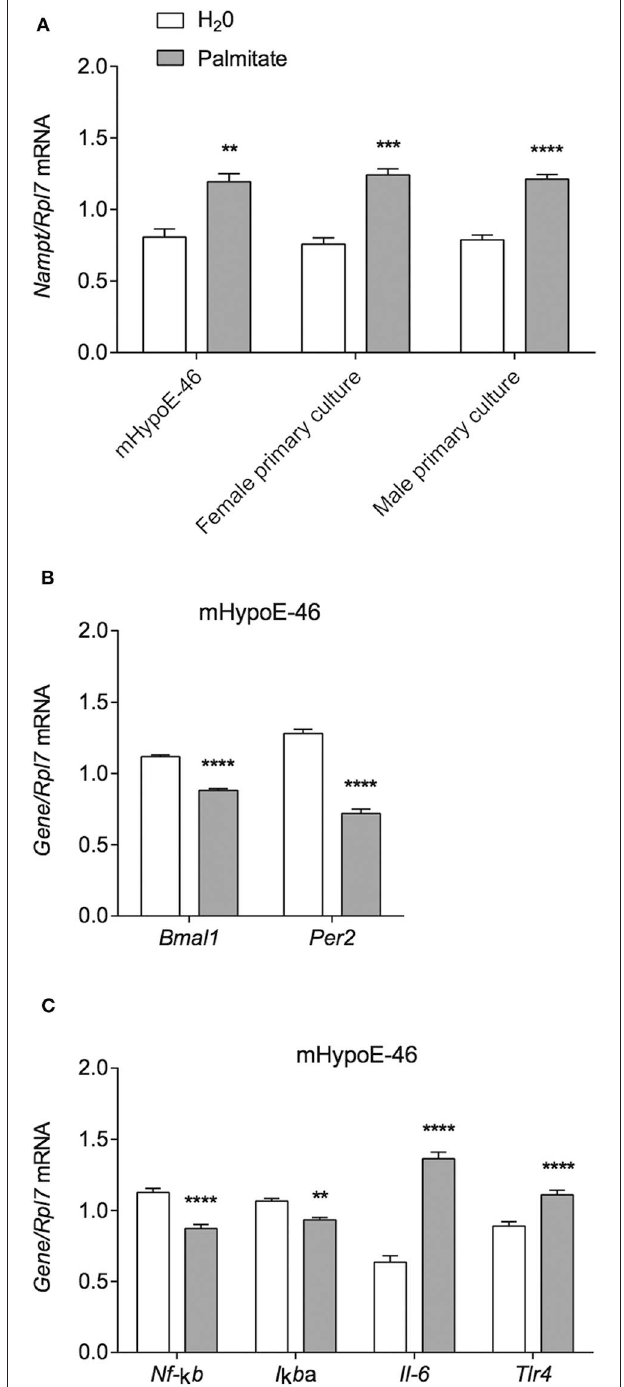
FIGURE 1 | Palmitate alters expression of Nampt , core circadian clock genes, and inflammatory genes. mHypoE-46 neurons, as well as primary hypothalamic cultures derived from male and female CD-1 mice were treated with 50 µ M palmitate for 24h. Changes in mRNA expression of (A) Nampt , (B) Bmal1 and Per2 , or (C) Nf- κ b , I κ B α , Il-6 , and Tlr4 were assessed by qRT-PCR. n = 4 independent experiments. Data are expressed as mean ± SEM; ** P < 0.01, *** P < 0.001, **** P < 0.0001 Statistical analysis was performed with an unpaired t -test.